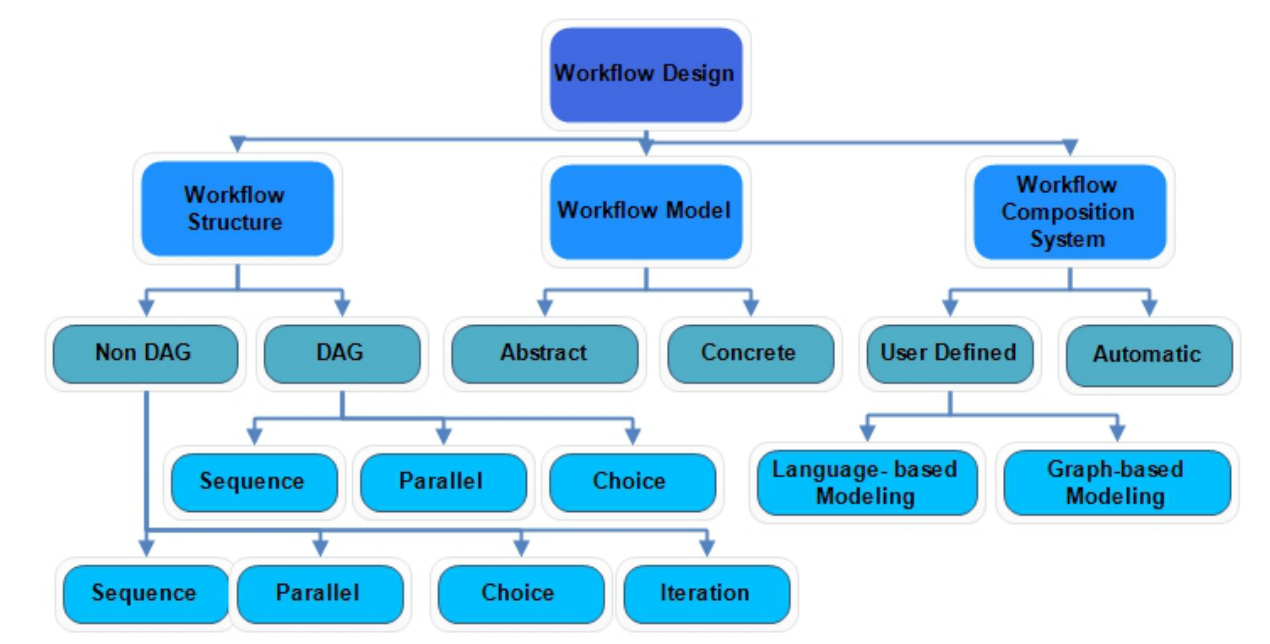
Figure 2. Aspects of workflow design